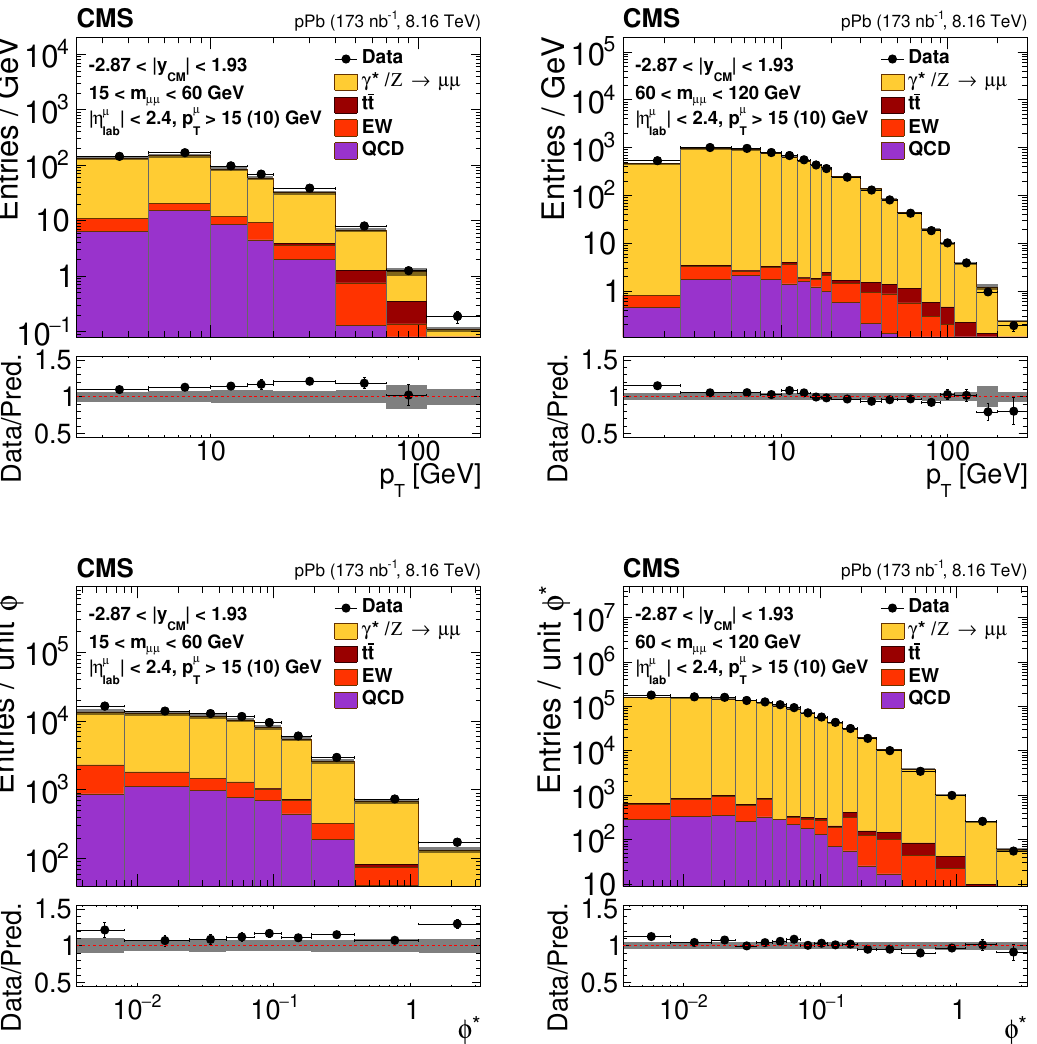
Figure 2 . Comparison of the data (black points) with the Z / g ∗ signal and background expectations (filled histograms, where “EW” includes Z / g ∗ → t + t − and diboson), estimated as described in the text, as a function of p (upper row) and φ ∗ (lower row), for 15 < m < 60 GeV (left) and T mm 60 < m and φ ∗ distributions start at 0. Vertical error < 120 GeV (right). The first bins of the p T mm bars represent statistical uncertainties. The ratios of data over expectations are shown in the lower panels. The boson p reweighting described in the text is not applied. The shaded regions show the T quadratic sum of the systematic uncertainties (including the integrated luminosity, but excluding acceptance and unfolding uncertainties) and the nPDF uncertainties